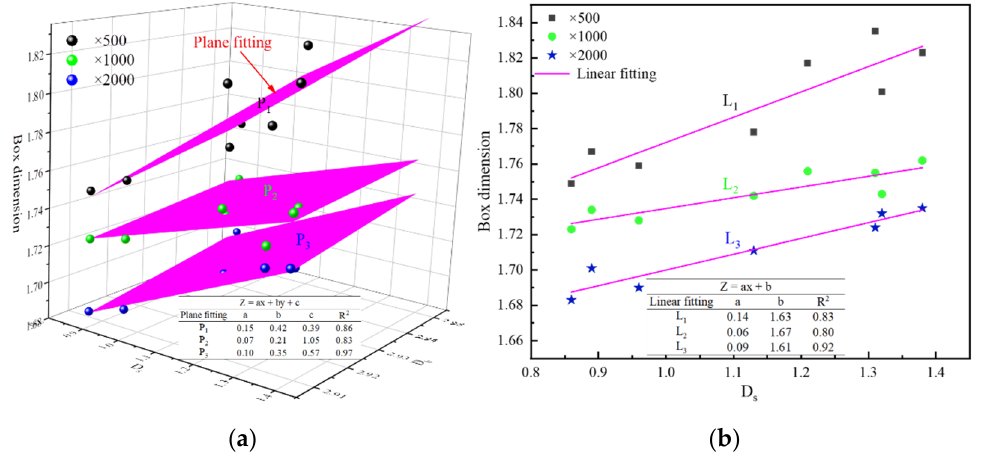
Figure 13. Relationship between NMR-FT fractal dimension and SEM-FT box dimension. ( a ): Rela- tionship between SEM-FT box dimension and each type of pore NMR-FT fractal dimension. ( b ): Relationship between SEM-FT box dimension and small pore NMR-FT fractal dimension.